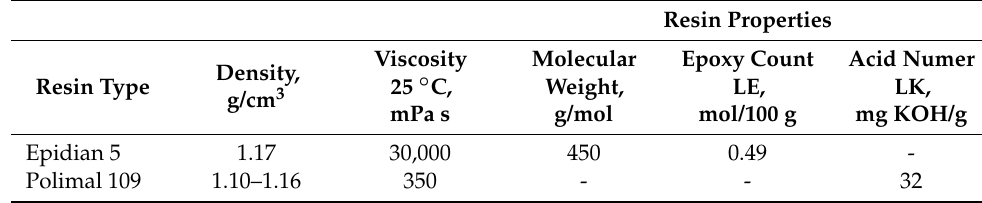
Table 2. Selected properties of resin binders.